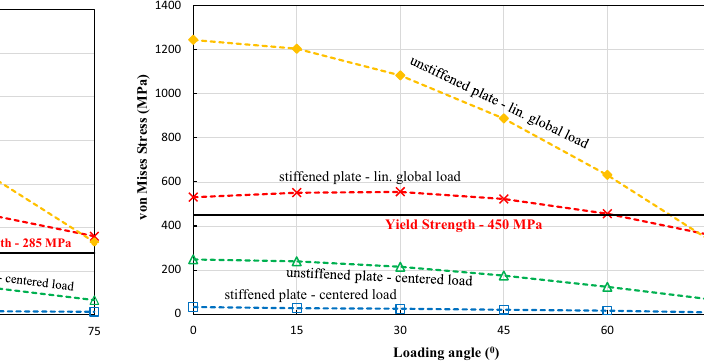
Figure 6: Maximum von Mises stress of sti ff ened and unsti ff ened low - carbon steel materials.